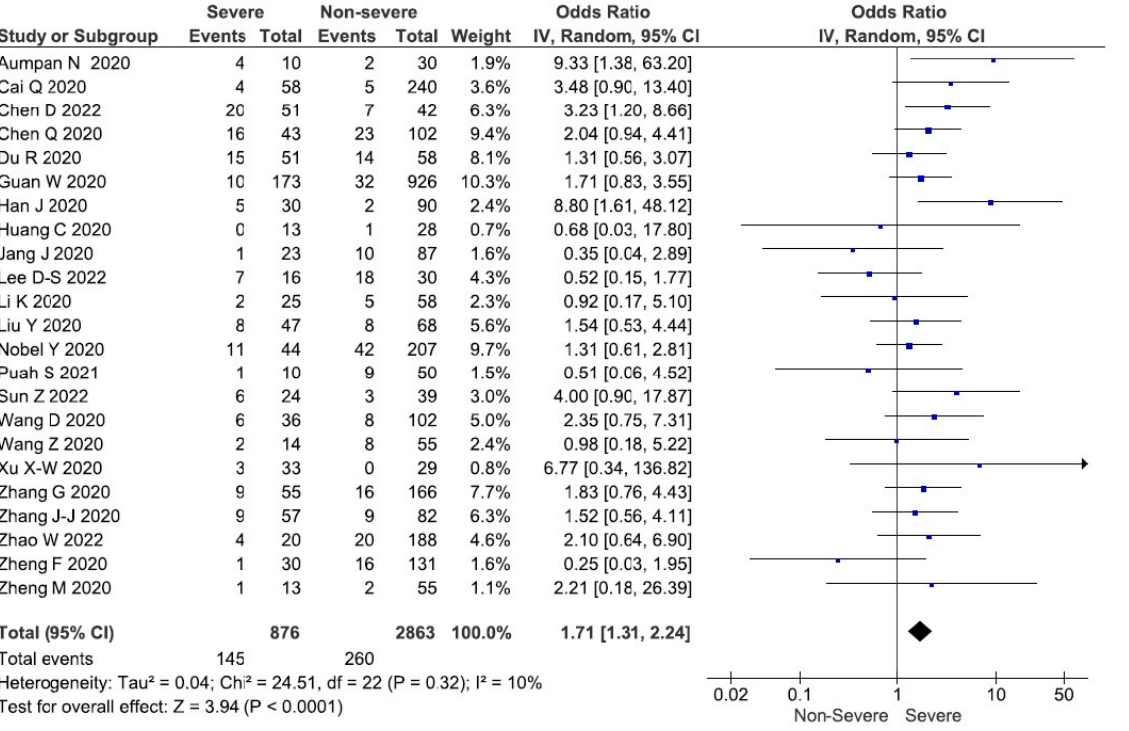
Figure 2. Forest plot demonstrating that in COVID-19 patients who have diarrhoea is associated with more severe COVID-19 outcome when the pooled odds of patients with non-severe diarrhoea versus severe diarrhoea are compared.